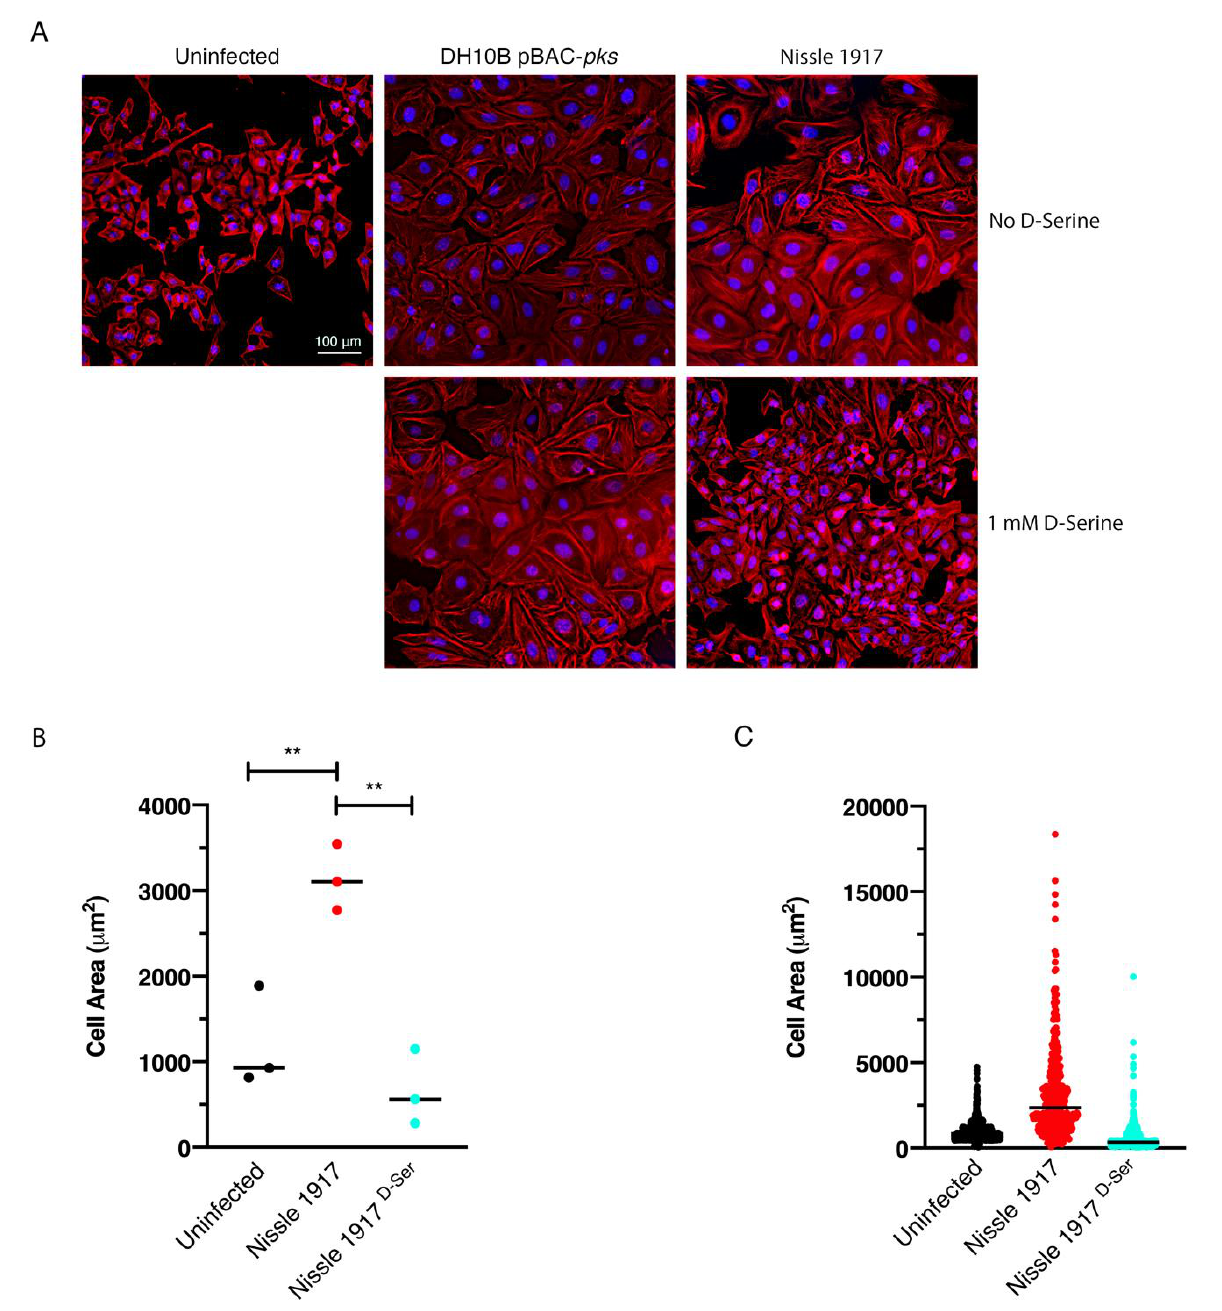
FIGURE 5: Exposure to D-Serine reduces the colibactin associated cellular senescence. HeLa cells were infected for 4 h with E. coli Nissle 1917 or DH10B hosting BAC- pks (MOI = 400). Infections were performed with and without the addition of 1 mM D-Serine to the growth media. At 8 h after infection, cells were washed and incubated for 72 h to allow for the megacell phenotype to develop. ( A ) HeLa cell mor- phology was observed by wide field fluorescence. Actin cytoskeleton was stained with Phalloidin in red and DNA was counterstained with DAPI in blue at 72 h post infection. Scale bar = 100 μm. ( B ) CellProfiler software was employed to measure the area of the HeLa cells shown in A using images acquired at 10X magnification. 100 cells were measured per sample. Columns represent the mean cell area measured with individual experimental observations indicated by data points for each infection condition. Measurements were acquired from images taken from three independent e xperiments and statistical significance was assessed by unpaired Student’s t -test with, ** indicating P < 0.01. ( C ) Individual cell area measurements were recorded across triplicate experiments. Black lines indicate the OPEN ACCESS | www.microbialcell.com